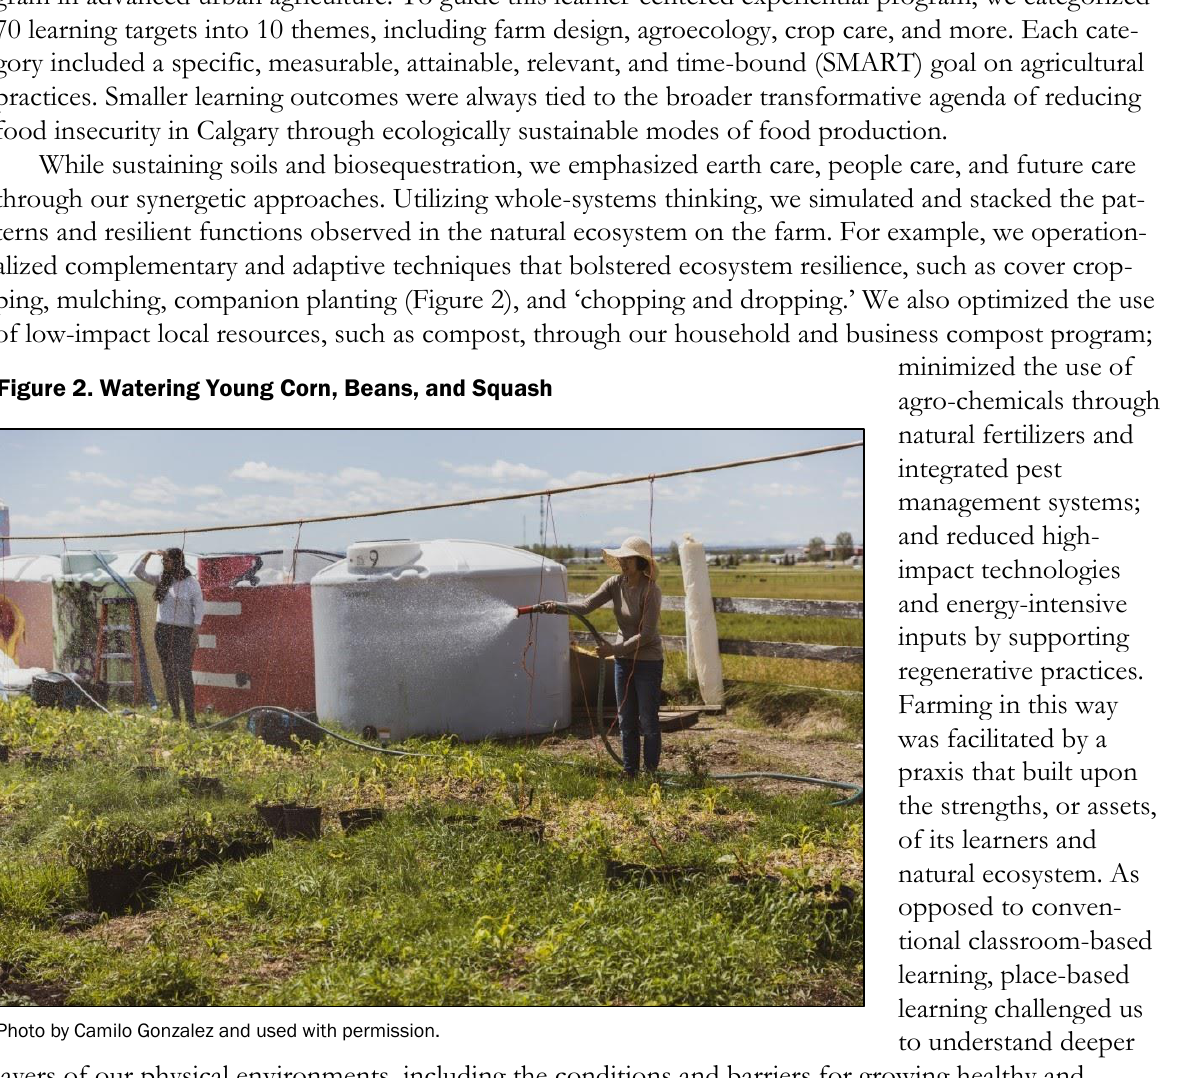
Photo by Camilo Gonzalez and used with